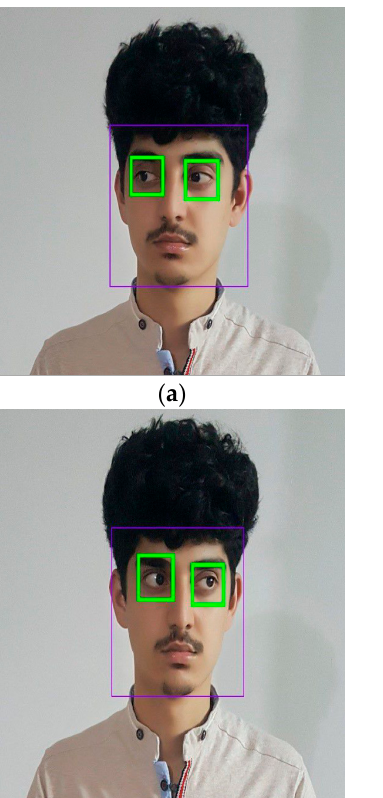
Figure 2. Gaze interaction and bounding box formation.